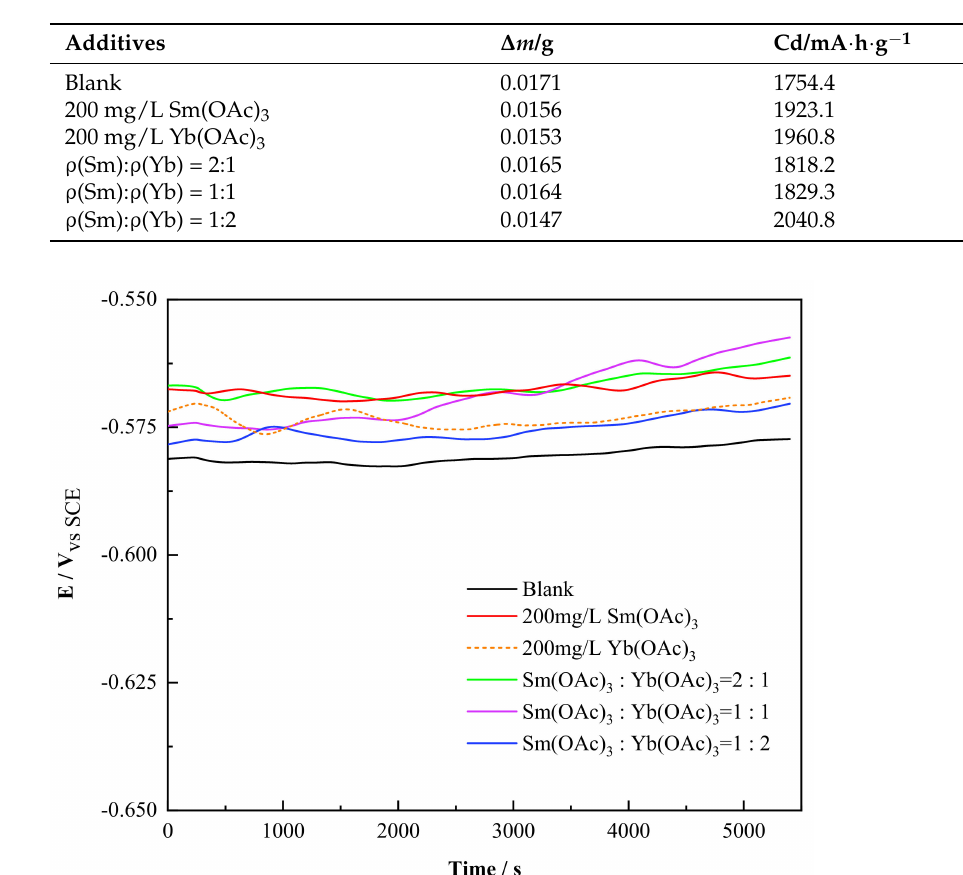
Figure 6. Galvanostatic discharge curves of 7075 anodes in different electrolytes at a current density of 20 mA · cm − 2